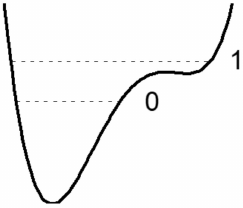
Figure 2. Proton potential function for a moderate hydrogen bond, d O ··· O ~ 2.6